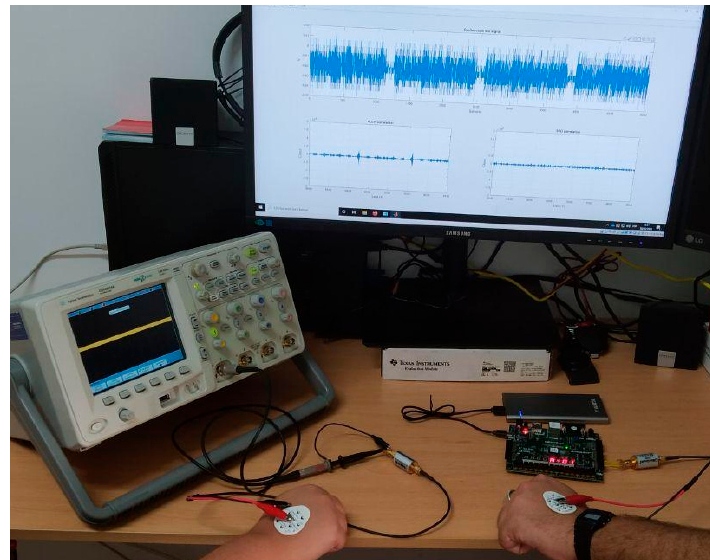
Figure 9. Experimental prototype.